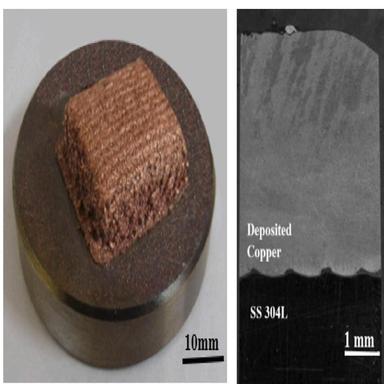
Increasing LEPF scheme (a) Pictorial view of block (b) Cross-section showing porosity.